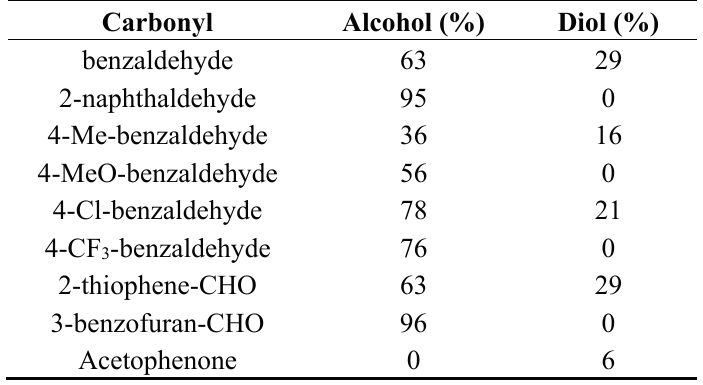
Table 4. P25 SCPC reductions of carbonyl compounds to primary alcohols a